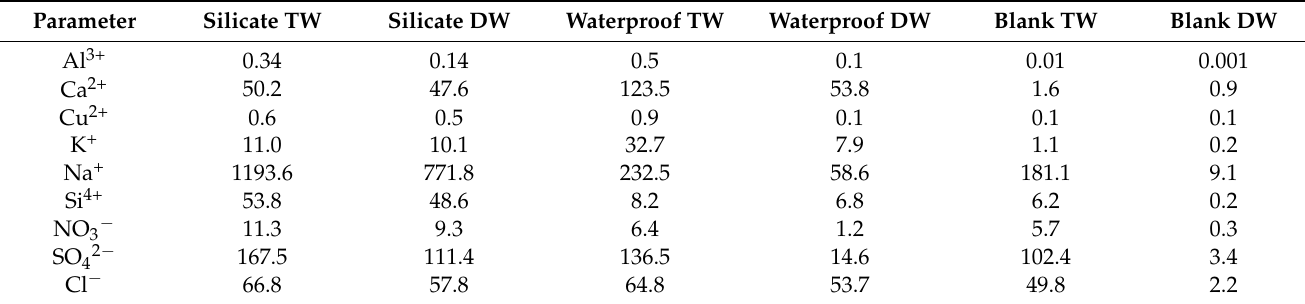
Table 1. Inorganic characterization of the eluates: mean values for leachings and blanks in mg/L. Parameter Silicate TW Silicate